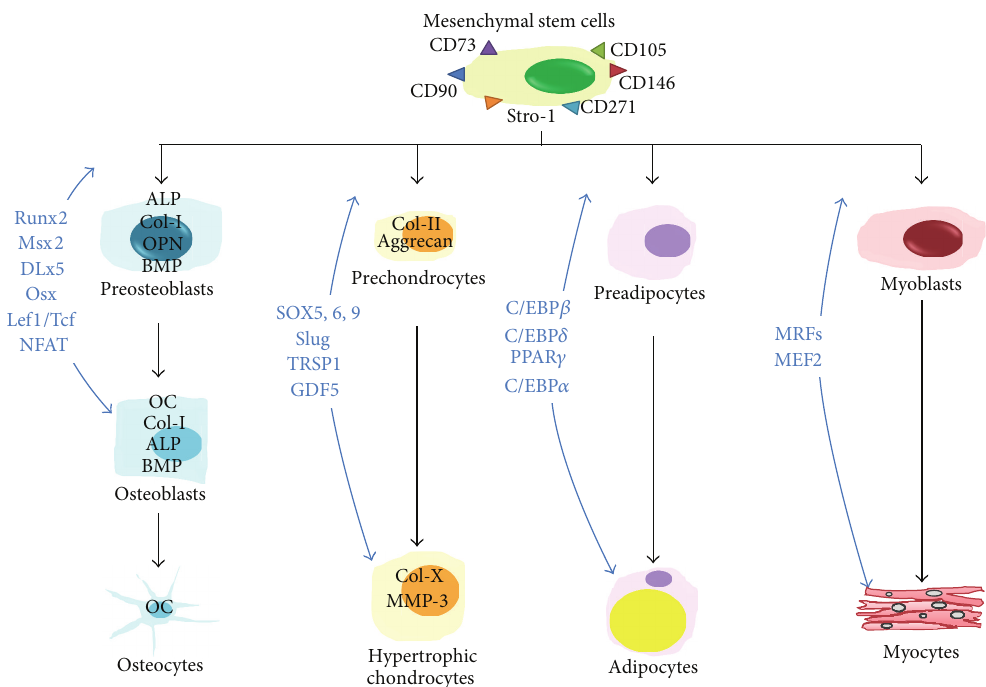
Figure 1: Multipotent differentiation of BM hMSCs. The commitment and differentiation of hMSCs towards osteogenic, chondrogenic, adipogenic, or myogenic lineage are regulated by specific transcription factors (indicated in blue). ALP, alkaline phosphatase; Col-I, type I collagen; OPN, osteopontin; BMP, bone matrix protein; OC, osteocalcin; Col-II, type II collagen; Col-X, type X collagen; MMP-3, matrix